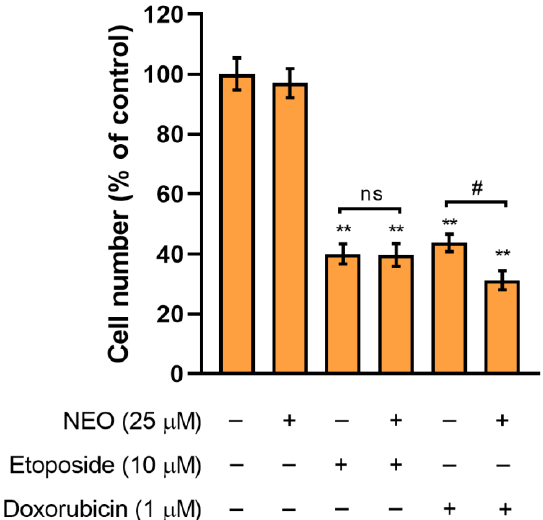
Figure 3. The effect of the combined treatment of NEO (25 µ M) and doxorubicin (1 µ M) or etoposide (10 µ M) on the growth of SW1783 cells. Data are presented as percentages of the control. ** p < 0.001 vs. control; # p < 0.05 for comparisons between groups; ns—non-significant difference.